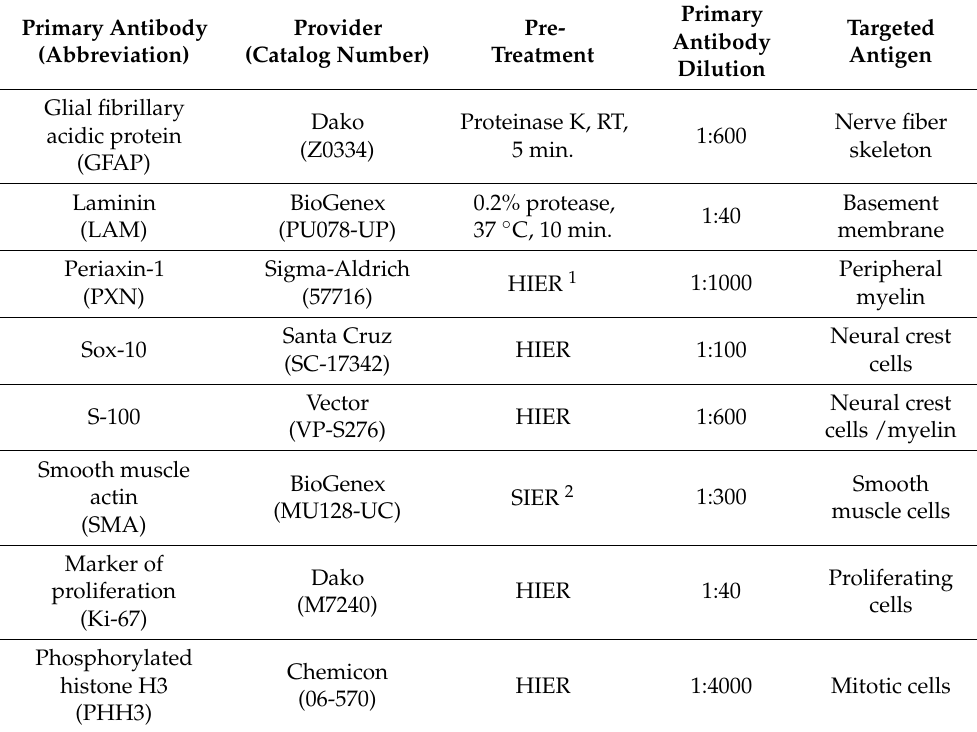
Table 1. Detailed information of antibodies included in the